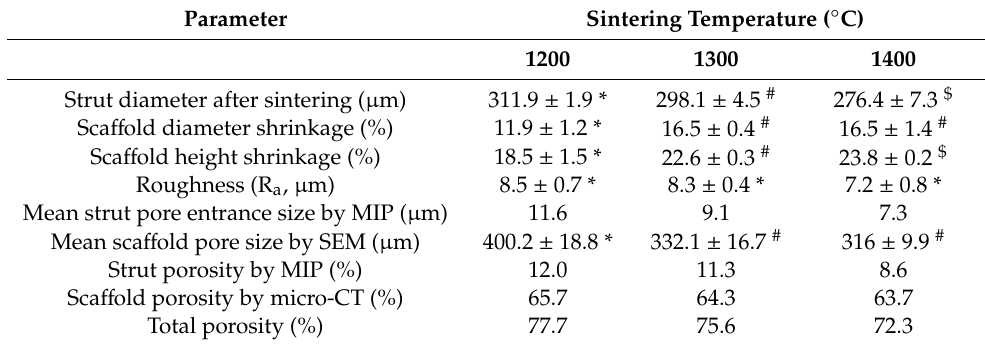
Figure 4. Images of 3D-printed scaffolds: ( a ) optical image of the scaffold; ( b ) SEM micrographs of the green body and ( c ) SEM micrographs after the complete thermal treatment, including the debinding and subsequent sintering at 1200 °C. Table 2. Characterization of the Ti sca ff olds sintered at 1200 ◦ C, 1300 ◦ C and 1400 ◦ C: strut diameter after sintering, percentage of sca ff old shrinkage, surface roughness and porosity. Samples with di ff erent symbols (*, # , $ ) present statistically significant di ff erences ( p <